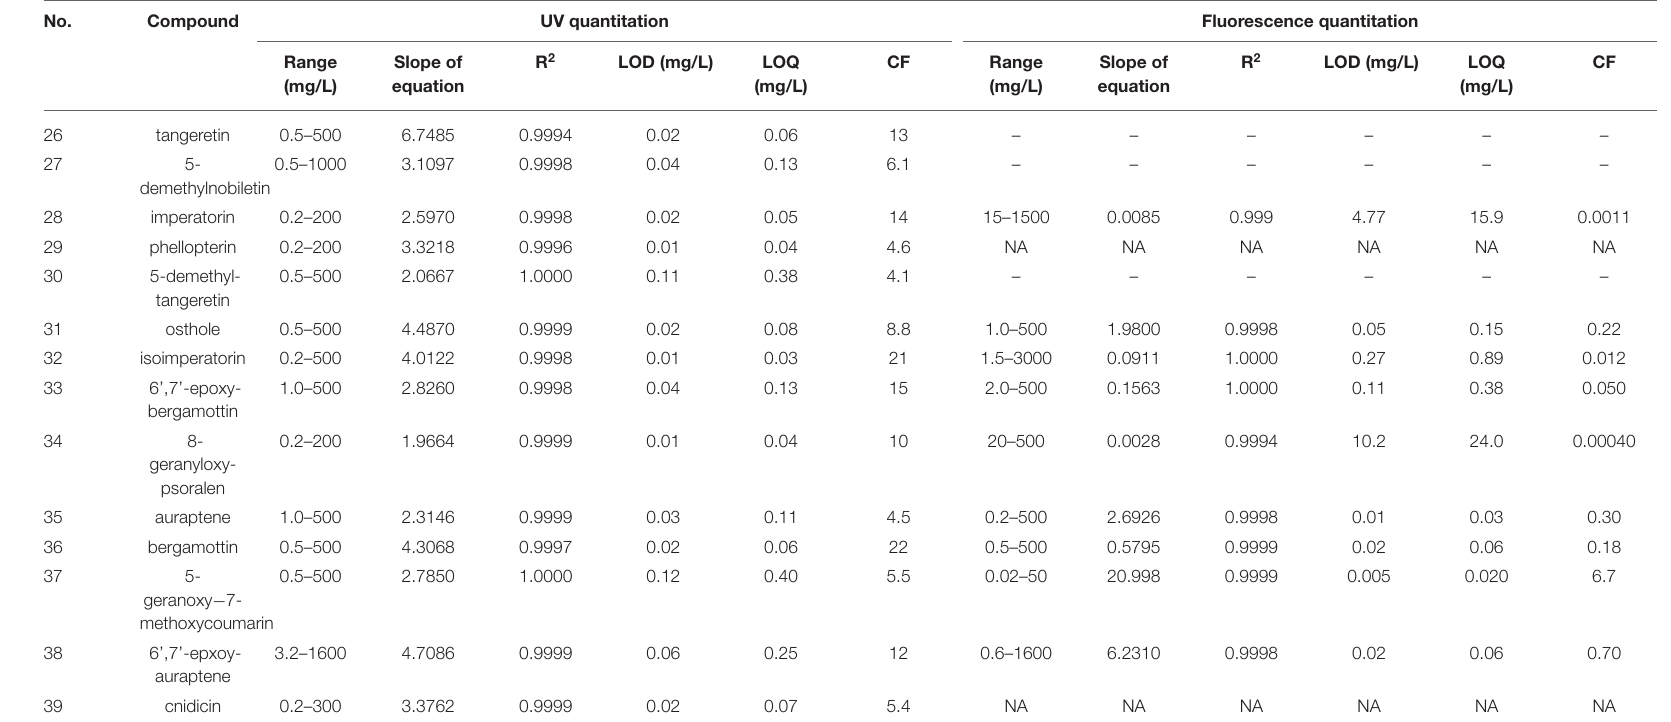
NA, not available for quantitation because of the low emission response; - fluorescence emission not